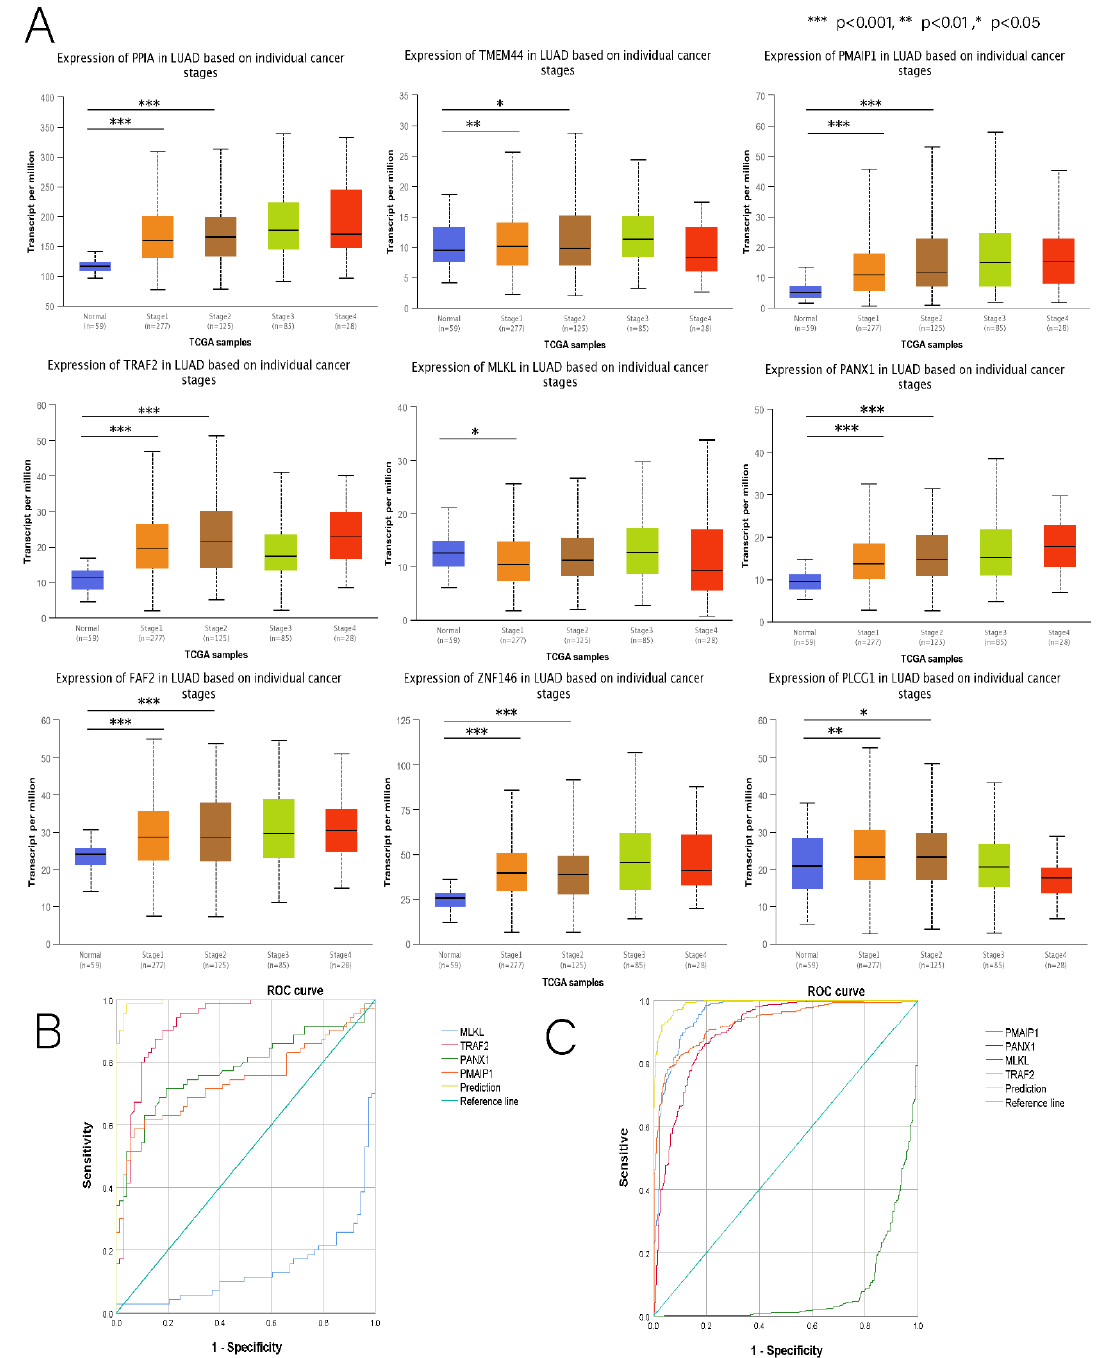
Figure 14. ( A ) Relationship between nine DENRGs and clinicopathological staging in the prognostic model. ( B ) ROC curves of the LUAD diagnostic model when GSE75037 was used for the training set. ( C ) ROC curves of LUAD when TCGA was used for the test set. * p < 0.05, ** p < 0.01, and *** p <